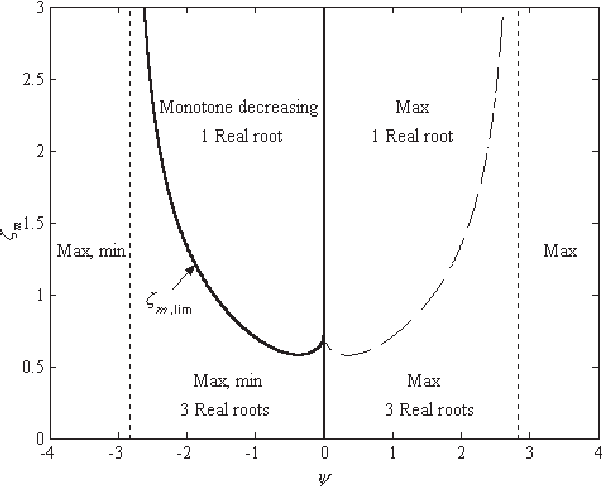
Fig. 15. Behaviour of FRF modulus of the complex damped SDOF